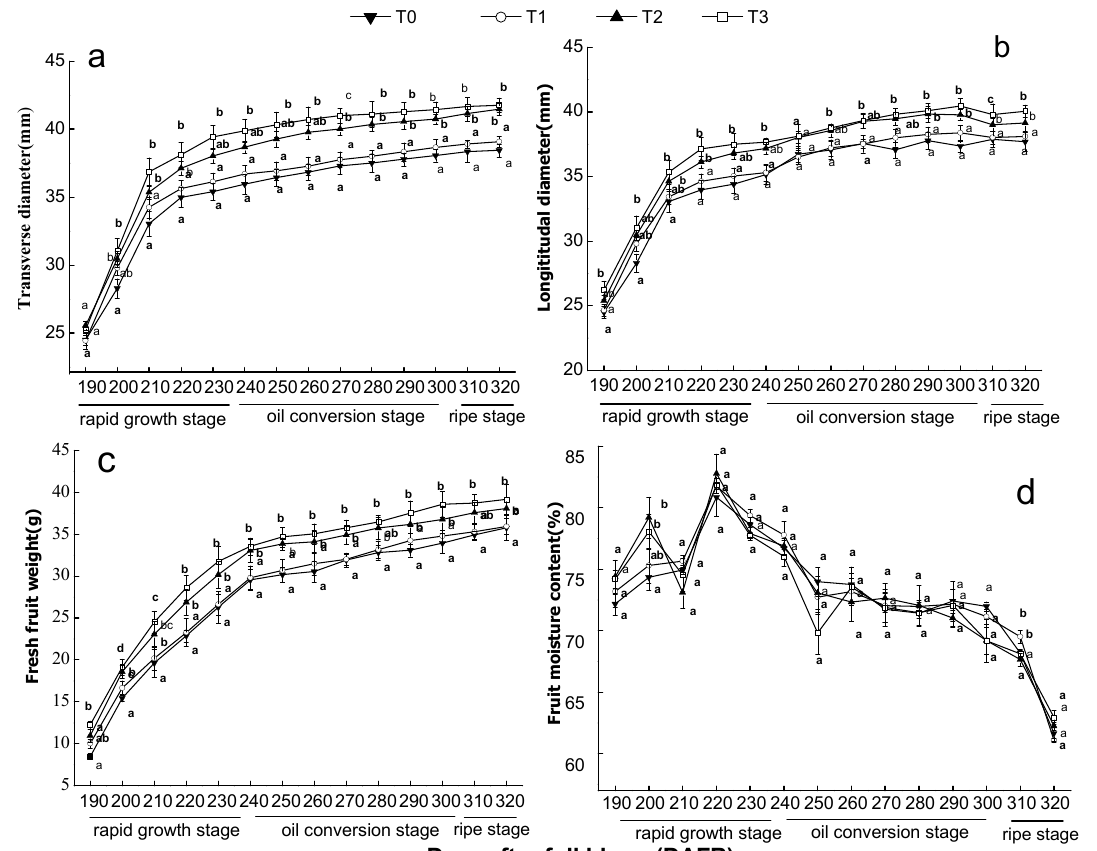
Figure 1. Changes in the transverse diameter ( a ), longitudinal diameter ( b ), weight ( c ), and moisture content ( d ) of C. oleifera fruits under different flower treatments from 190 days after full bloom (DAFB) to 320 DAFB. Treatments: T0, removed 0% of the tree flowers; T1, removed 20% of the tree flowers; T2, removed 40% of the tree flowers; T3, removed 60% of the tree flowers. Values represented are means ± S.E. ( n = 3). Different lowercase English letters (a, b, c and d) in the graph indicate significant differences between treatments ( p <